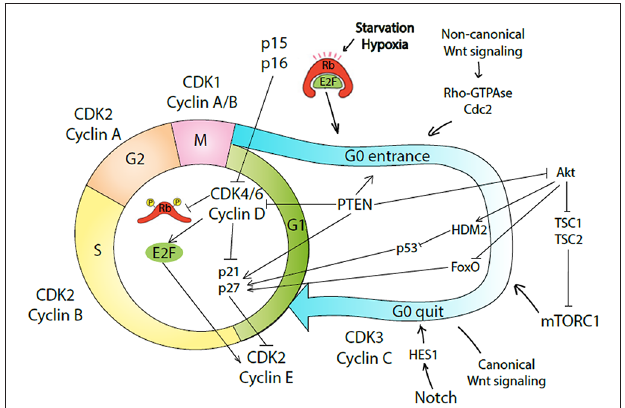
FIGURE 1 | Molecular mechanisms underlying entrance and quite G0-phase of cell cycle by cancer stem-like cells (CSCs). Conventional four phases of the cell cycle are regulated by a specific complex of cyclin and cyclin-dependent kinase (CDK). The regulatory machinery of G1 progression overlaps with decision mechanism about the commitment to quiescence or proliferation. In case of GFs/mitogens availability, CDK4/6/cyclin D complex phosphorylates Rb causing E2F release, which in turn activates cyclin E. CDK2/cyclin E complex drives G1 to S phase transition. CDK4/6/cyclin D complex also removes p21 and p27 inhibition on CDK2. Cells in G1 phase can exit the cell cycle and enter G0 phase as quiescent, senescent, or differentiated cells. In case of nutrition withdraw or hypoxia, Rb renders E2F bound and as a result CDK2/cyclin E complex is inhibited by p21/p27. Alternatively, activation of non-canonical Wnt (ncWnt) signaling causes quiescence induction via Rho-GTPase/Cdc42 complex. PTEN causes G0 entrance by inhibiting CDK4/6/cyclin D complex or Akt pathway. As a result, cells are driven into quiescence. CDK3/cyclin C complex, Notch, canonical Wnt (cWnt) signaling, or Akt/mTORC1 pathway can drive cells to enter cell cycle again. In response to mTORC1 signaling, quiescent cells can transit into the GAlert phase and become poised for rapid cell cycle